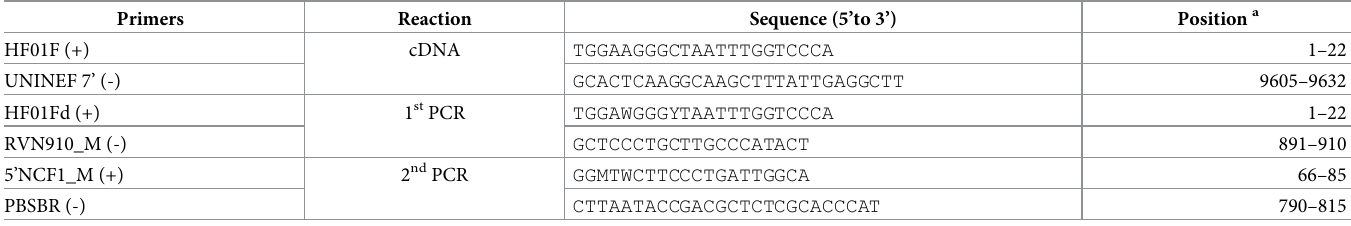
Table 1. Primers used for amplification of the 5’end of the HIV-1